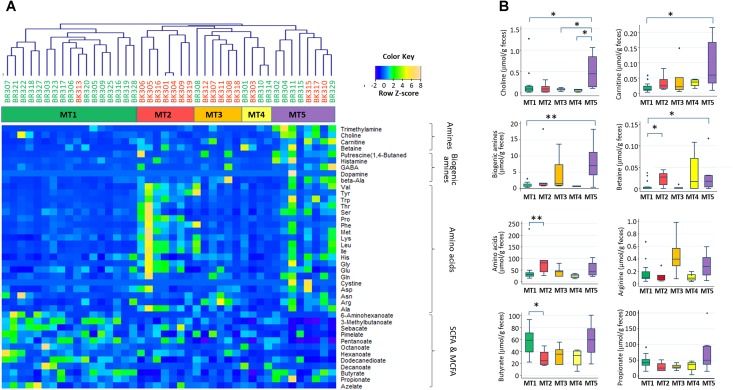
Five metabolotypes based on the measurement of 214 metabolites in stool samples from children in Bangkok and Buriram. Metabolites characterizing fecal metabolotypes were selected, and their abundances are shown in a heat map (A) and box plots (B). (A) A hierarchical clustering dendrogram was generated based on Pearson’s correlation determined based on the abundance of whole metabolites (see Supplementary Figure S3). Samples colored by subjects’ city of residence and clusters colored by metabolotype were shown between the dendrogram and heat map. The abundance of each metabolite was converted to a Z-score across all samples and displayed in the heat map according to the above color key. (B) Single and double asterisks indicate p < 0.1 and p < 0.05, respectively, in a pairwise Wilcoxon rank-sum test with Bonferroni adjustment. “Biogenic amines” represent the sum of beta-alanine, dopamine, gamma-aminobutyric acid, histamine, phenethylamine, putrescine, and tyramine. “Amino acids” represent the sum of 20 standard proteinogenic amino acids. Refer to Figure 1D for a description of the box plot.